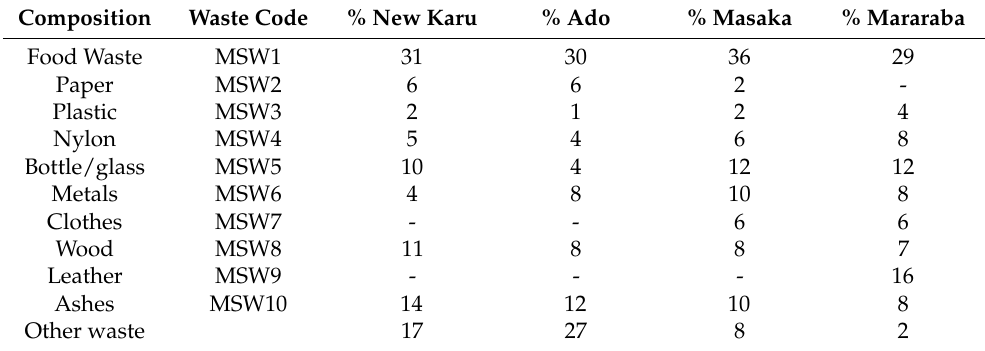
Table 1. Percentage composition of waste in GKUA.